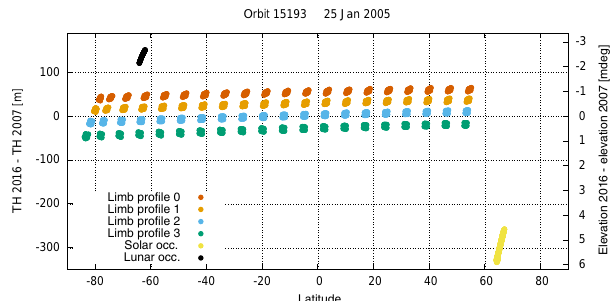
Figure 11. Tangent height changes for the limb and occultation measurements of orbit 15193 (25 January 2005) from the previous mispointing parameters to the ones derived